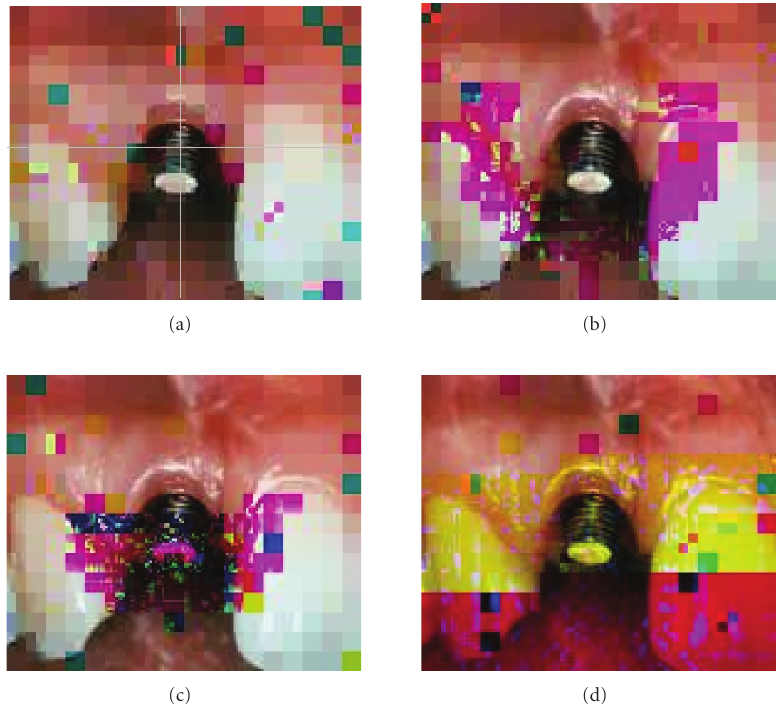
Figure 11: An example of quality of the decoded image with fixed length parity: (a) background image with the location of RoI in the center, (b) the image reconstructed at stage P 2 ; several subblocks in error in the area of RoI and some error subblocks in the vicinity of RoI, (c) the number of subblocks in error increases when the volume of the data in the receiver increases, that is, the resolution of the higher-priority regions increases, and (d) the complete transmitted